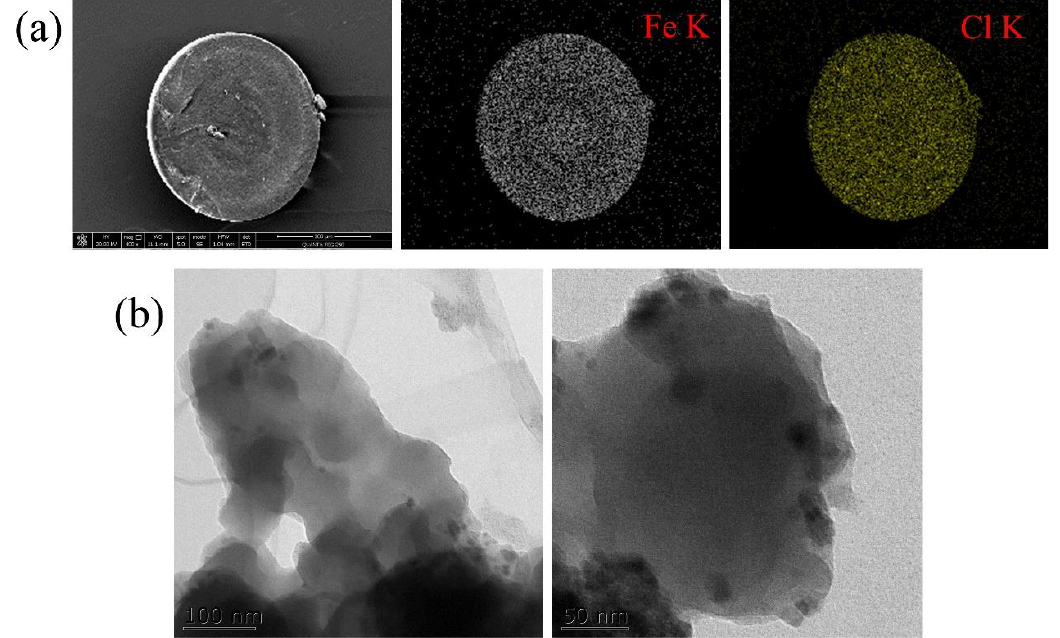
Figure 1. FESEM image of nZVI/PA composites with EDX spectra of elemental mapping in the cross section ( a ), and TEM images of nZVI/PA composites ( b ).